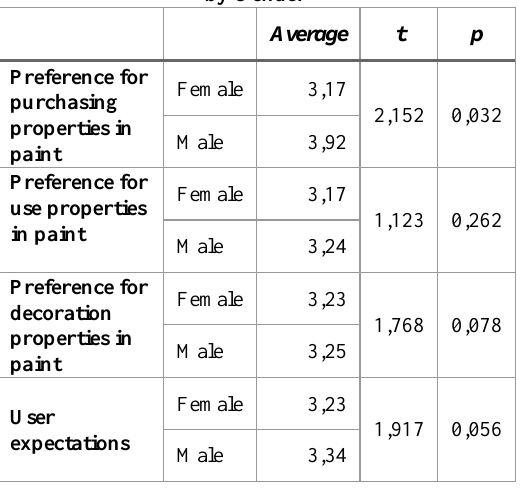
Table 15: t-test on Consumers' Preferences for Paint by Gender